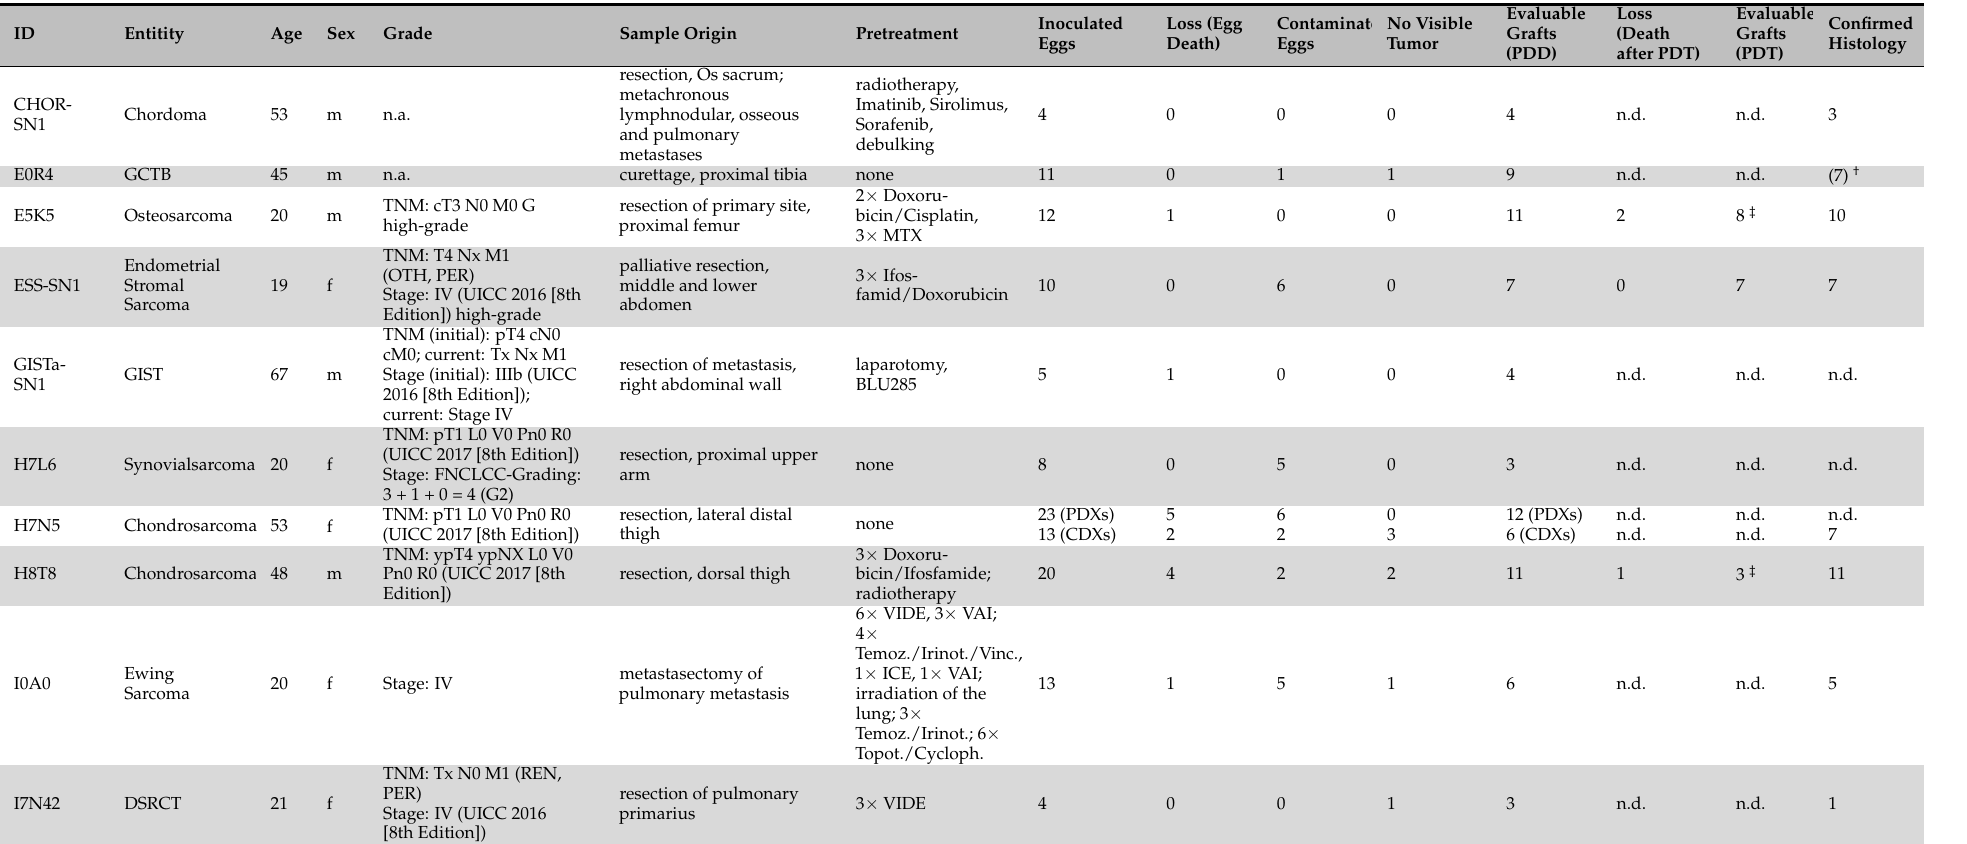
Table 1. Sample characteristics. M4M51 and M4M53 were derived from different samples of the same patient. * Information taken from https://www.cellosaurus. org/search (accessed on 5 January 2023). † Histologically not typical for GCTB. ‡ Some of the samples were of poor quality for de-termining regression rates after PDT and were therefore not considered for analysis, which explains the delta compared to evaluable samples in PDD. n.a. = Not applicable; n.d. = Not